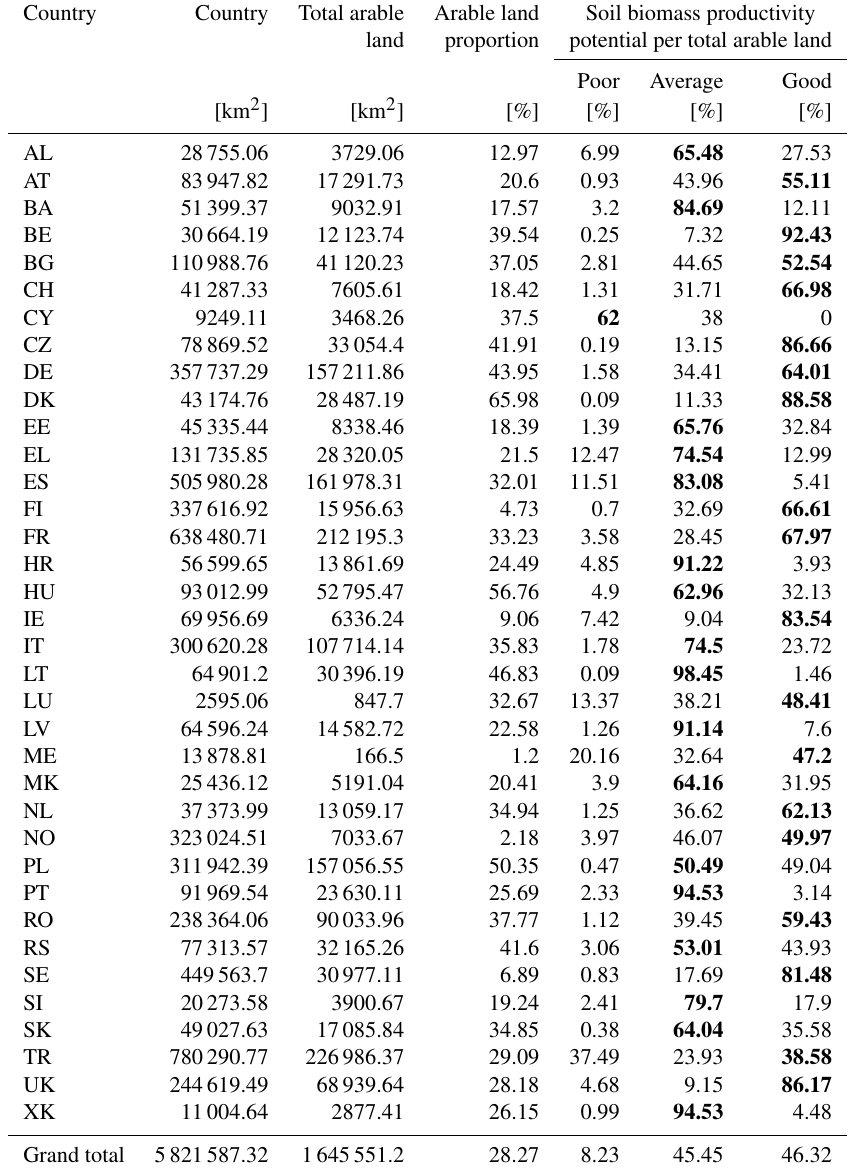
Table 2. Statistical distribution of arable lands according to their biomass production potential for each country (bold font shows the major share). Abbreviations of the countries are as follows: AL – Albania, AT – Austria, BA – Bosnia and Herzegovina, BE – Belgium, BG